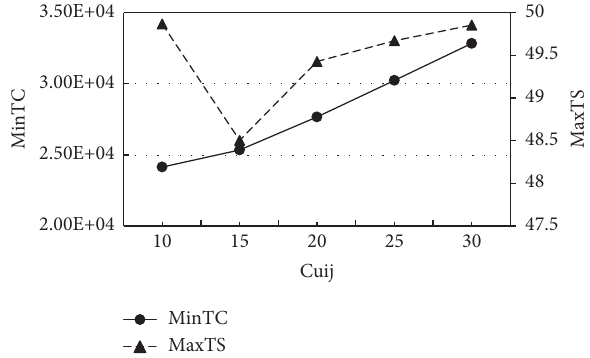
Figure 6: Sensitivity analysis of delivery cost.